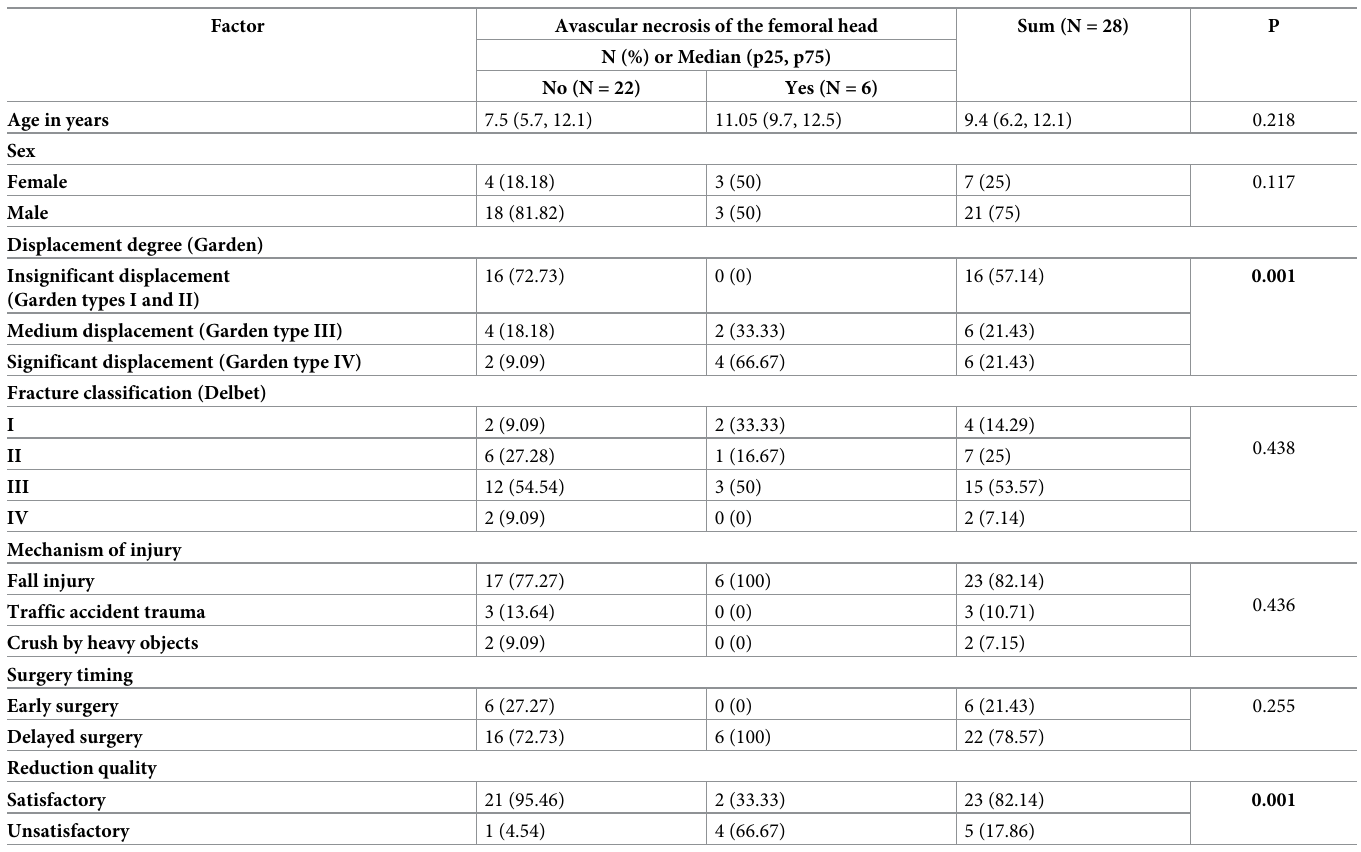
Table 2. Analysis of factors related to avascular necrosis of the femoral head in 28 children.